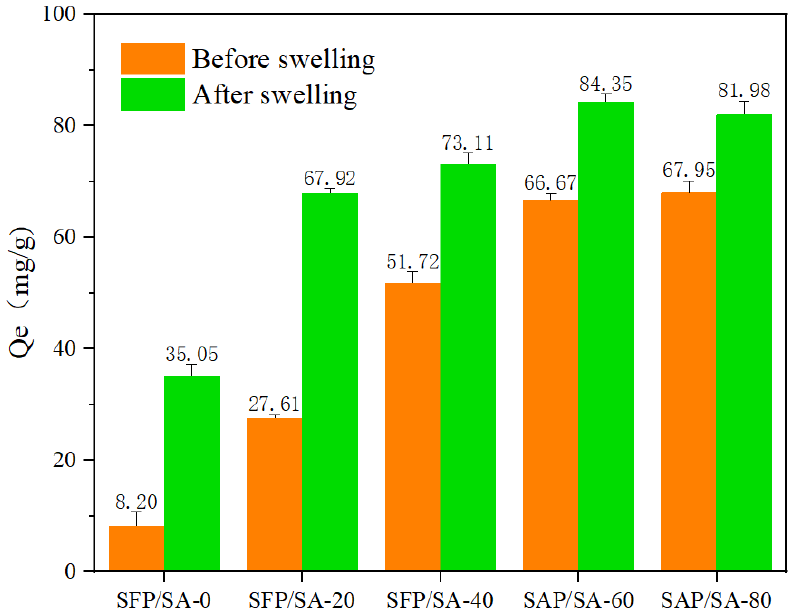
Figure 7. Research of the SFP/SA samples before and after swelling for adsorption capacity.